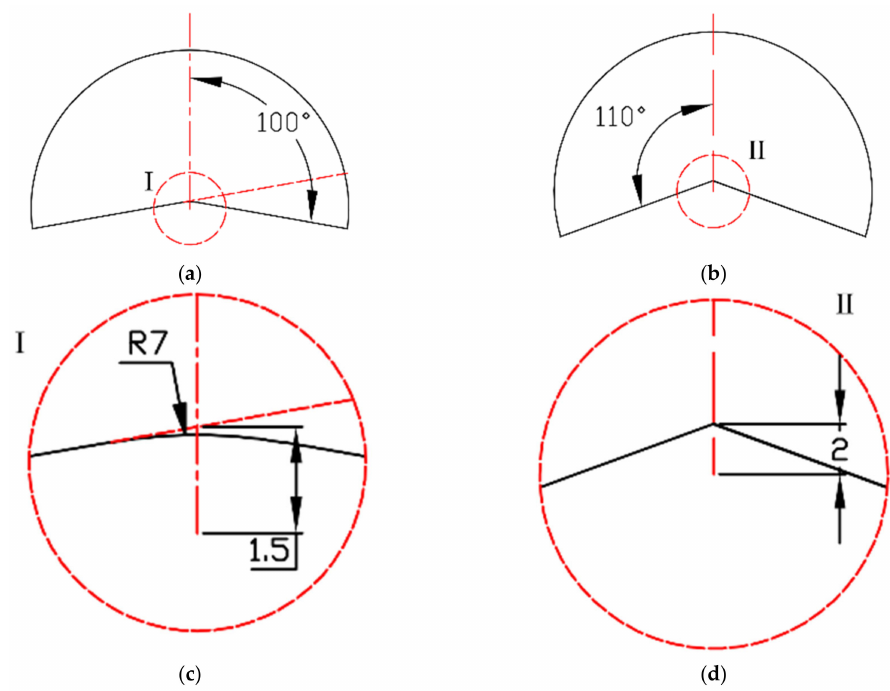
Figure 17. Comparison of the geometric structure of the susceptor before and after chamfering: ( a ) susceptor with chamfering; ( b ) susceptor without chamfering; ( c ) local amplification of position I to indicate the distance between the chamfered radian and the original inner corner tip position to the center of the outer arc; ( d ) local amplification of position II to indicate the distance from the inner corner tip position to the center of the outer arc.